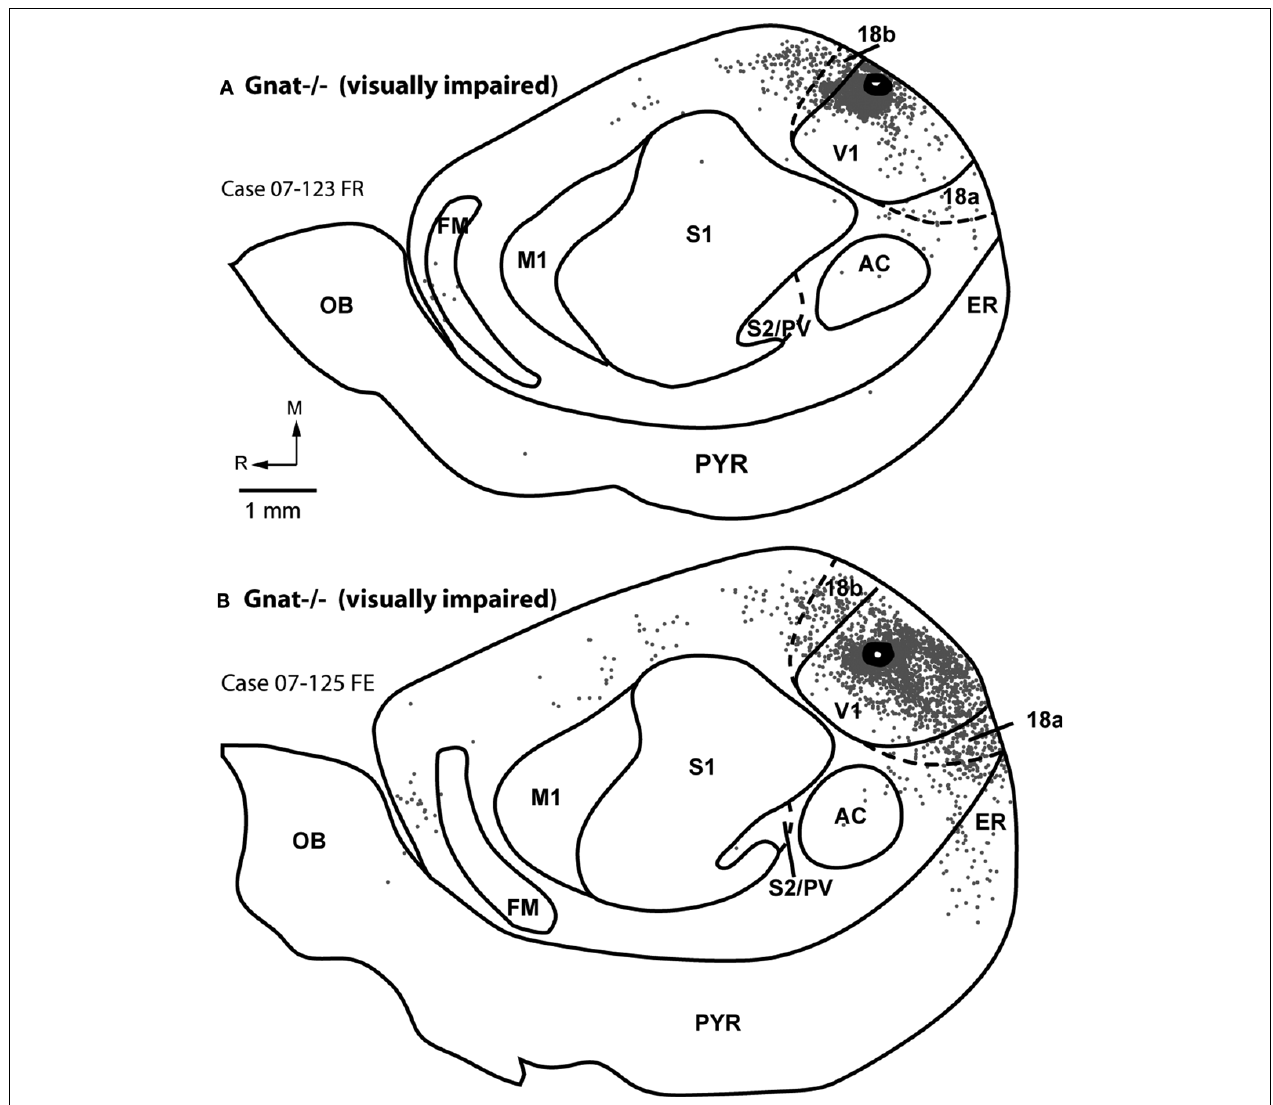
FIGURE 7 | Ipsilateral Cortical Reconstructions of Neuroanatomical Tracer Injections in Gnat − / − V1. Reconstructions of cortical connections in Gnat − / − mice (A,B) showing the location of retrogradely labeled cell bodies from neuroanatomical tracer injections in V1 relative to the architectonically defi ned cortical fi elds. The dots mark the locations of labeled cell bodies. The locations of